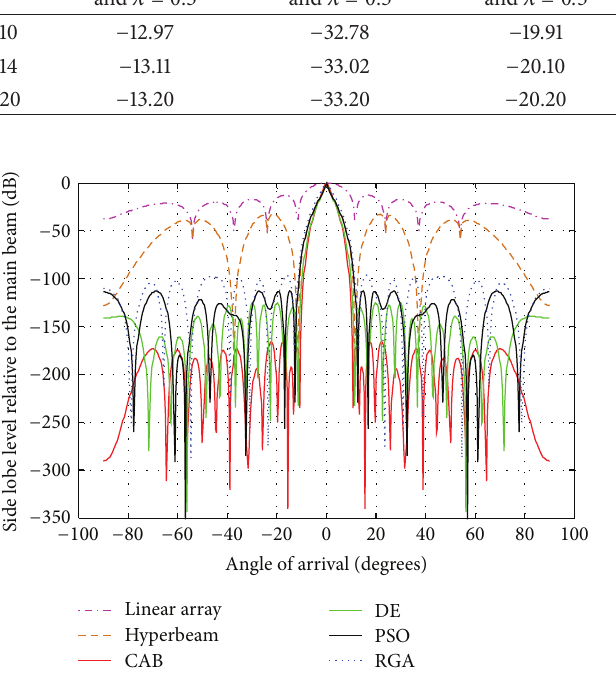
tions are − 19.91 dB, − 20.10 dB, and − 20.20 dB,